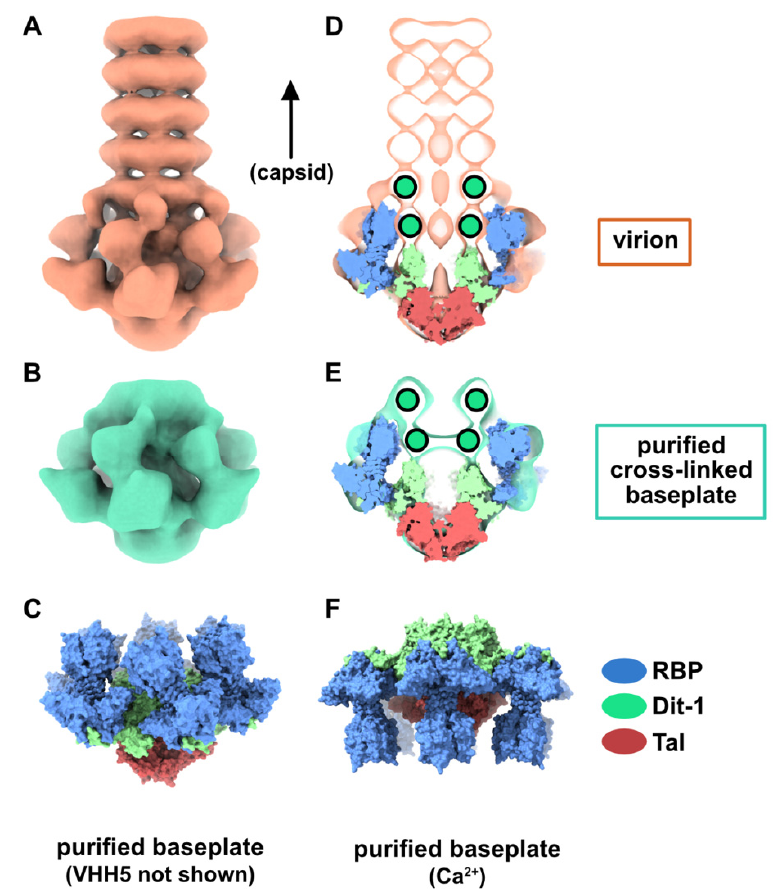
Figure 1. The resting and activated states of the phage p2 baseplate. ( A ) Negative-staining 3D reconstruction of phage p2 virion tail tip and baseplate (EMD-1699, [6]). The map is contoured at 2.5 σ . ( B ) CryoEM 3D reconstruction phage p2 purified and cross-linked baseplate (EMD-1706 [6]). The map is contoured at 2.5 σ . ( C ) Crystal structure of phage p2 purified baseplate in complex with VHH5 (PDB ID 2WZP, [6]). VHH5 molecules are not shown for clarity. ( D , E ) Central section of the 3D reconstructions shown in panels A and B with the baseplate crystal structure (shown in panel C ) fitted in the maps. The green / black dots indicate unassigned EM densities / EM density rings. ( F ) The crystal structure of phage p2 purified baseplate in activated conformation, with the receptor-binding domains pointing in the opposite direction to the capsid, is shown for comparison (PDB ID 2X53 [6]).